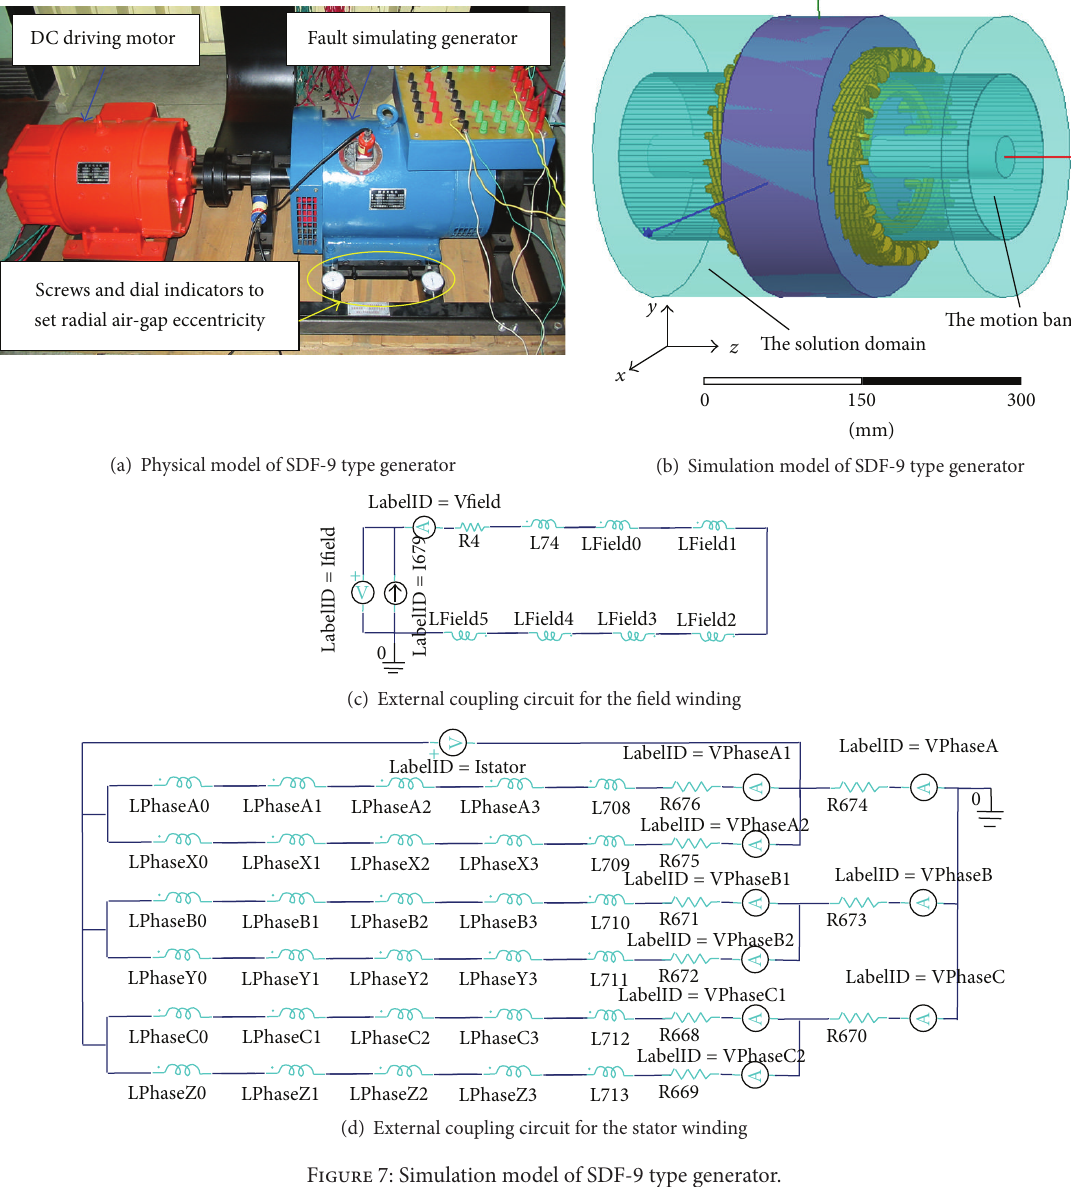
Figure 7: Simulation model of SDF-9 type